Question: Author a descriptive caption for the visualization shown.
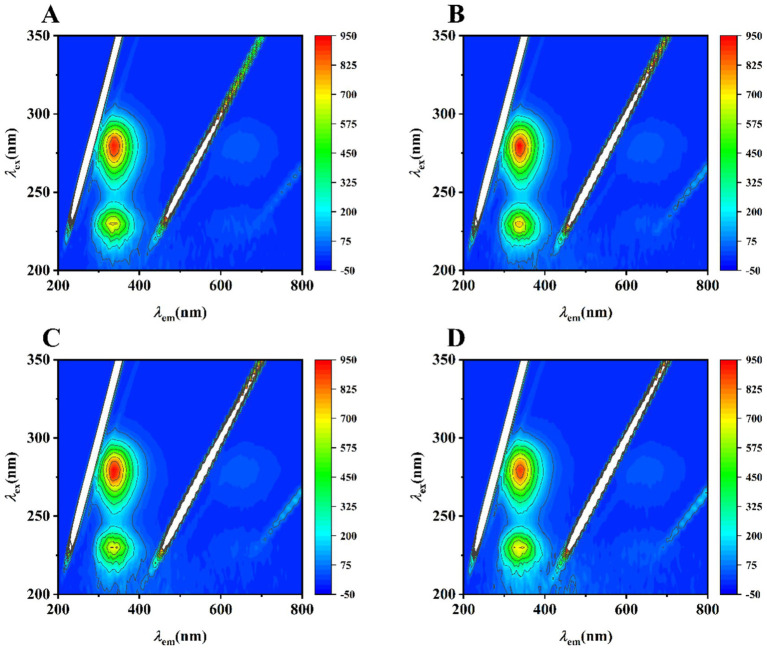
Answer: Three-dimensional fluorescence spectra of milk with different milk fat contents in 0% (A) , 2% (B) , 4% (C) and 6% (D) groups ( n = 3).